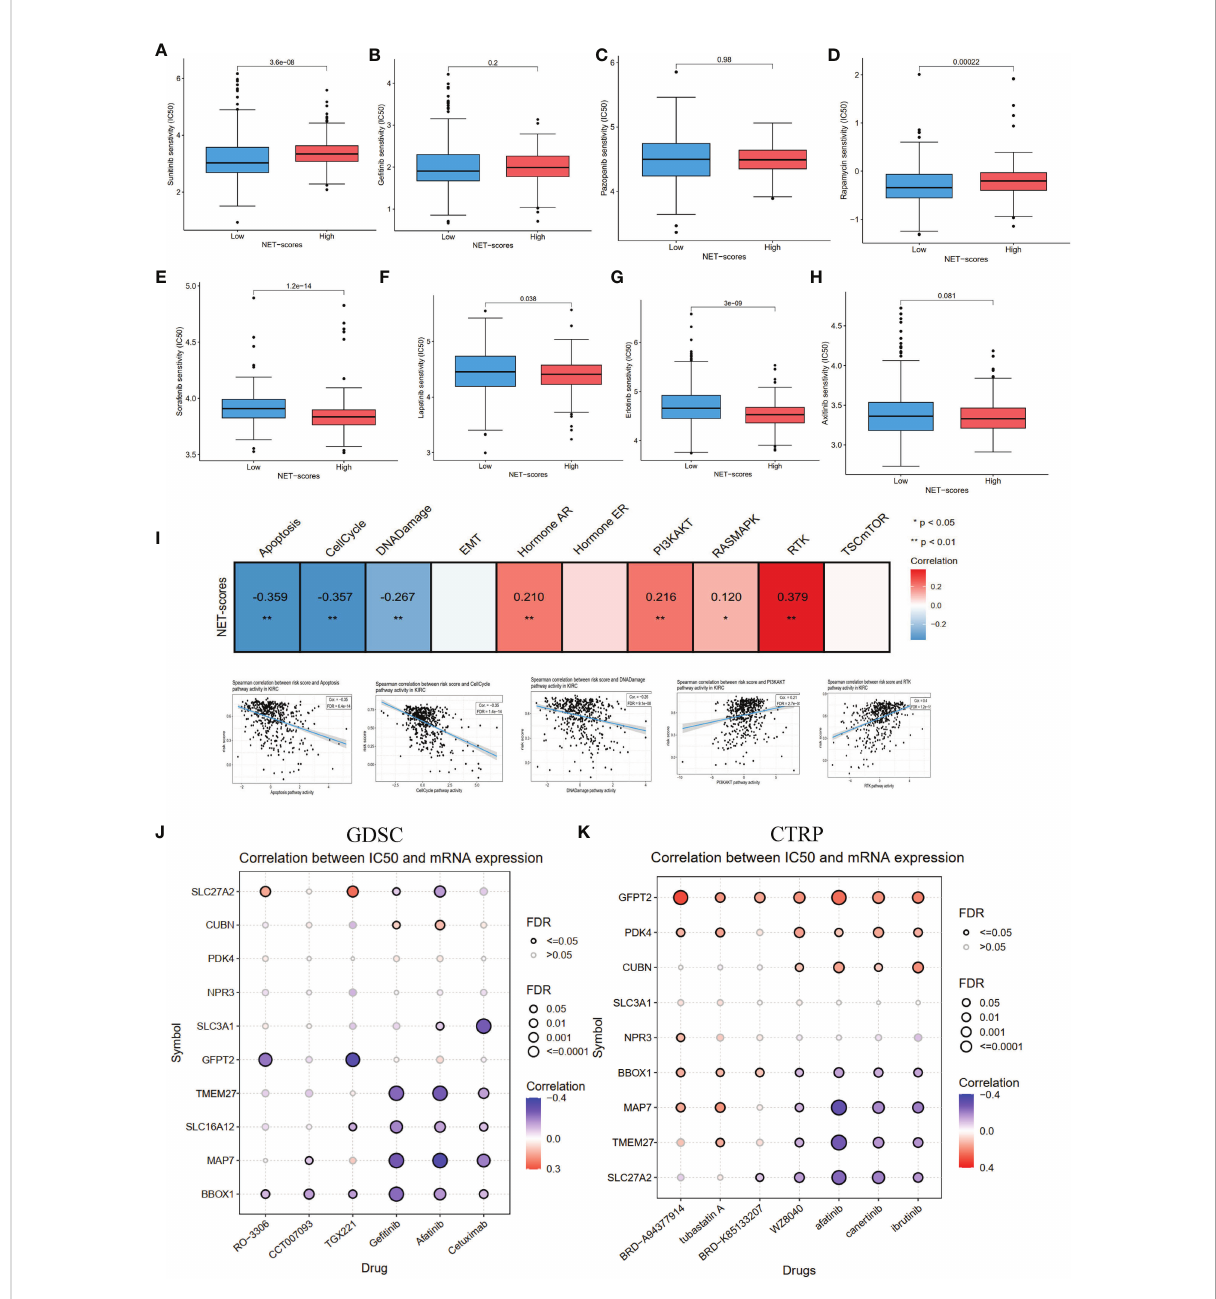
FIGURE 8 The pathway activity, drug sensitivity in ccRCC cohorts and pan cancer. (A – H) The drug sensitivity of eight common targeted compounds. (I) The associations of NET scores with activity pathways in the TCGA-KIRC dataset. (J) The correlation between gene expression and the sensitivity of GDSC drugs in pan-cancer. (K) The correlation between gene expression and the sensitivity of CTRP drugs in